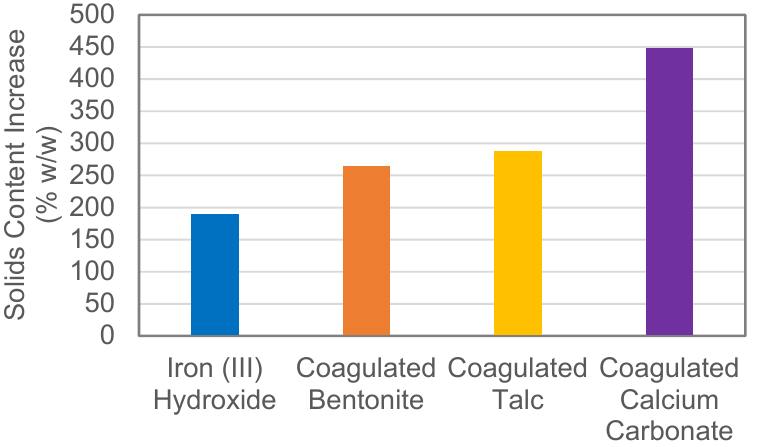
Figure 8. Percentage increase in solids weight fraction from settled coagulated mineral systems, based on consolidated bed density.